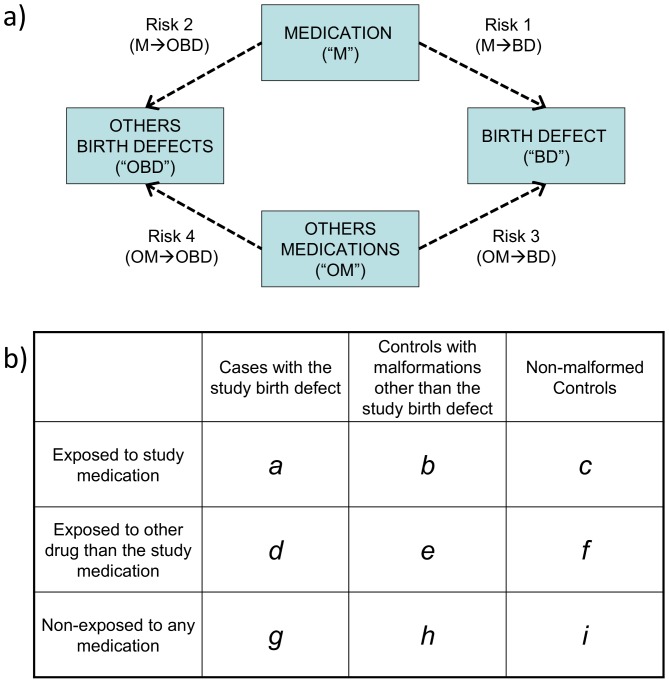
Prenatal exposure to medications and birth defects occurrence.(a) Potential relationships between prenatal exposure to medications and birth defects occurrence in the population; (b) Three-by-three contingency table of malformed and non-malformed newborns with prenatal exposure to the study medication, exposure to other medications, and non-exposed; cell frequencies are represented by the letters a, b, c, d, e, f, g, h, and i.